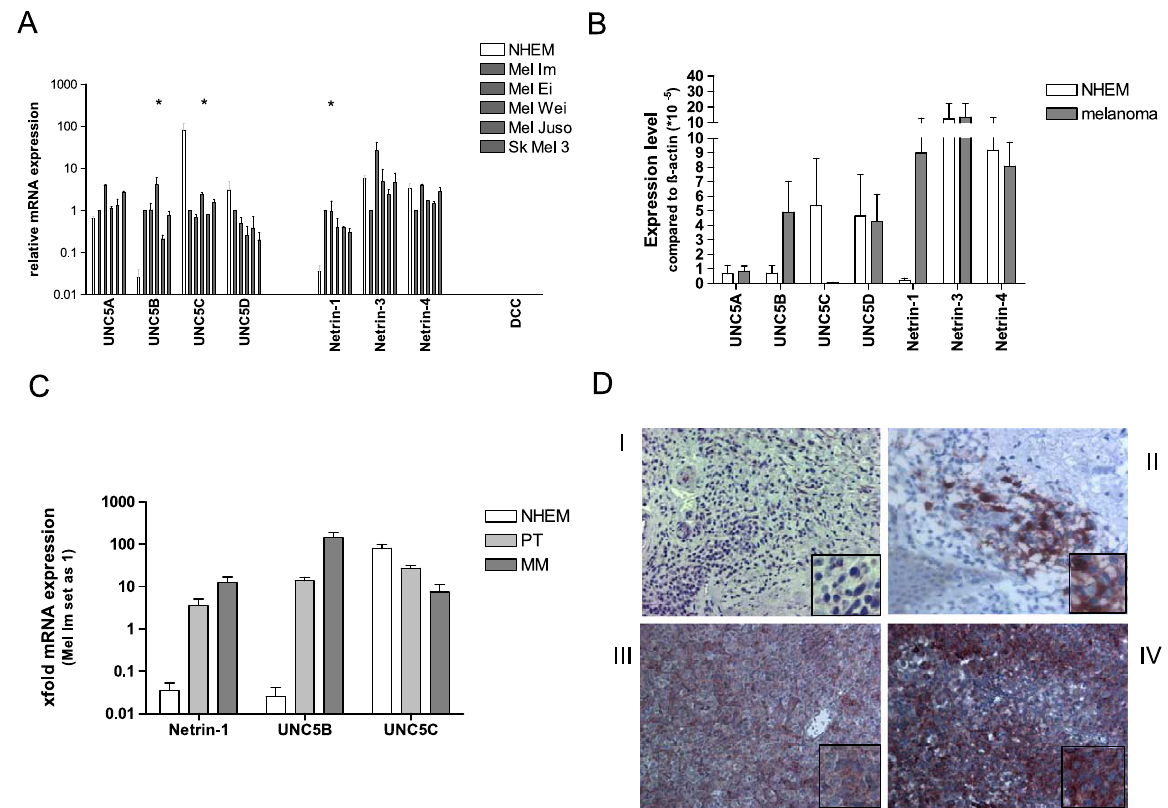
Fig. 1. Expression pattern of Netrin family repellent factors in melanoma. (A, B, C) expression of Netrins (Netrin-1, -3 and -4) and their receptors (UNC5A, B, C and D) and DCC was determined (A) in melanoma cell lines and normal human epidermal melanocytes (NHEM) and in (C) RNAs extracted from primary melanomas (PT, n = 7) and melanoma metastasis (MM, n = 6) by using quantitative RTPCR. In (B) expression of the molecules compared to actin are displayed to assess expression level. All experiments were performed in triplicate and repeated three times, bars display mean + SD, statistical analysis was performed using a Student’s unpaired t -test. (* p < 0 . 05.) (D) Immunhistochemical staining of Netrin-1 in melanoma samples revealed expression in the tumor cells. (I: nevus; II: primary melanoma; III–IV: melanoma